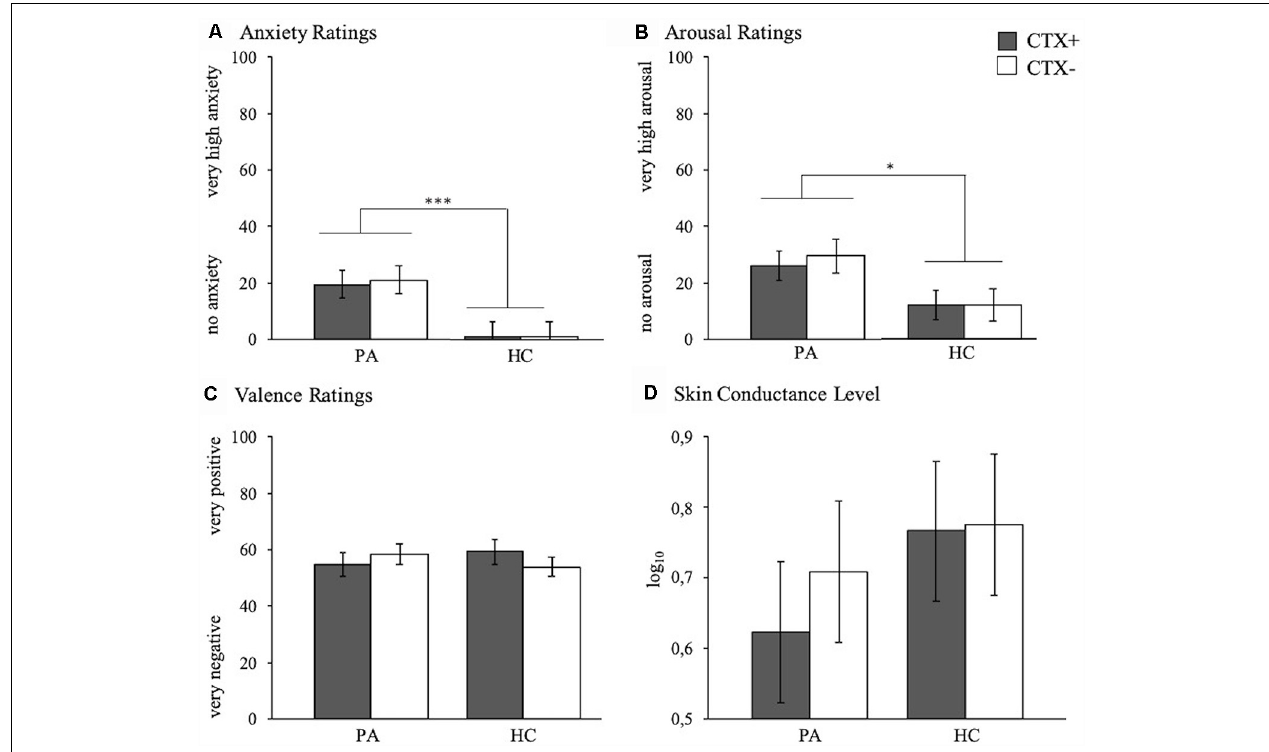
FIGURE 1 | Anxiety (A) , arousal (B) , and valence (C) ratings as well as skin conductance level (SCL) (D) of participants with panic attacks (PA, left bars) and healthy controls (HC, right bars) to the CTX+ (gray) and the CTX − (white) during the exploration phase. Depicted are mean responses (means and standard errors). ∗ p < 0.050, ∗∗∗ p <